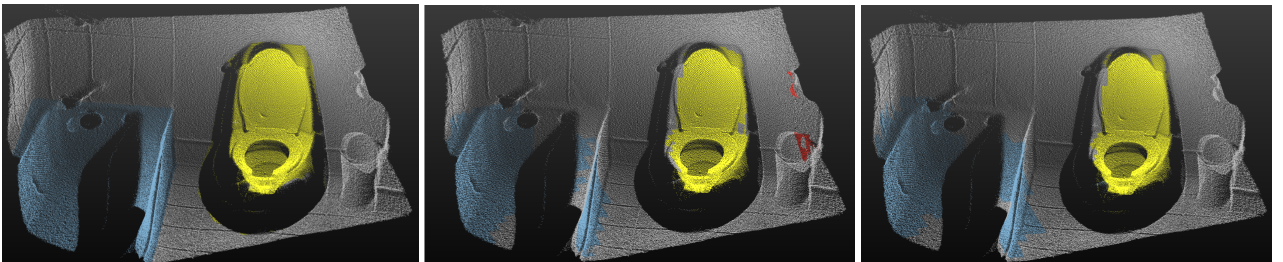
Figure 18. Visualizations of 3D segmentation results: Left is the ground truth. The middle is the prediction based on the frustum generated from the RGB color image. The image’s red color is the predicted segmentation for a false positive Chair during the 2D detection stage. Segmentation prediction based on the frustum generated from the DHS image is shown in the right